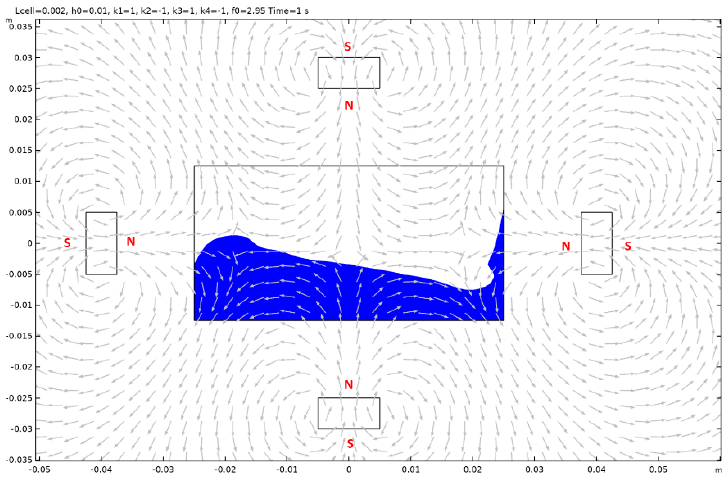
Figure A25. Case 11.